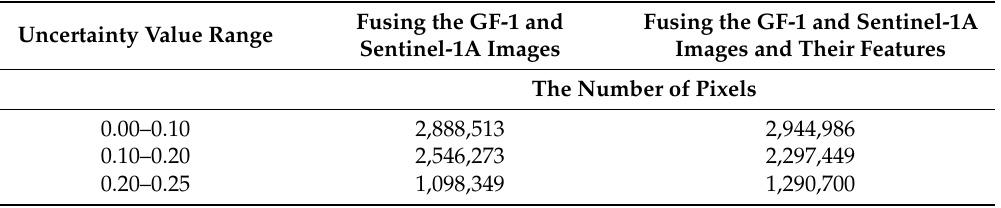
Table 7. The number of pixels falling into the different uncertainty value ranges for impervious surfaces derived by fusing different data